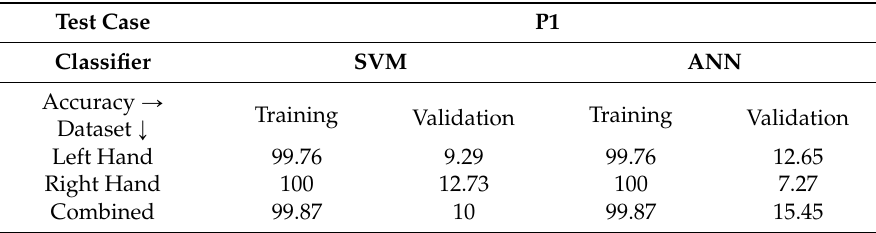
Table 7. Training and validation set accuracies (User Specific, after PCA).